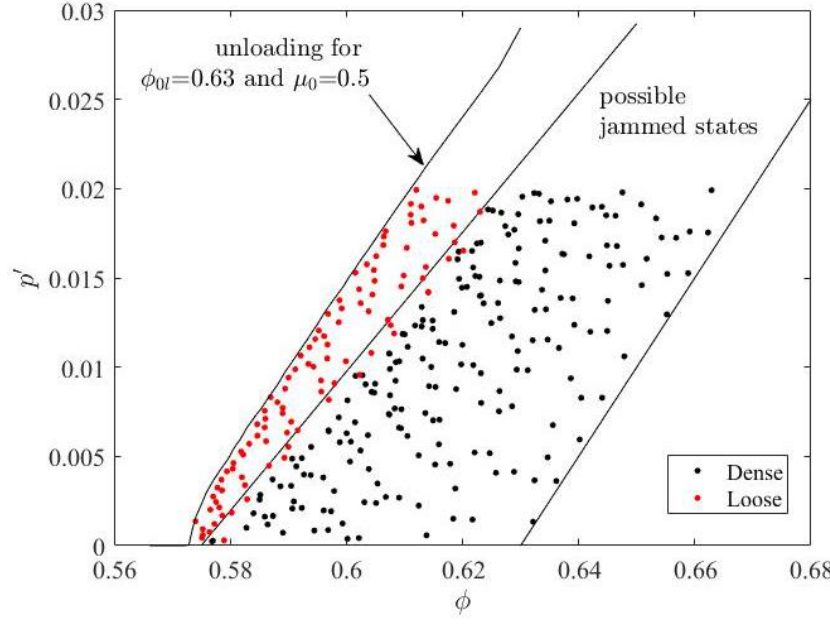
Figure 3. Varying-friction method.